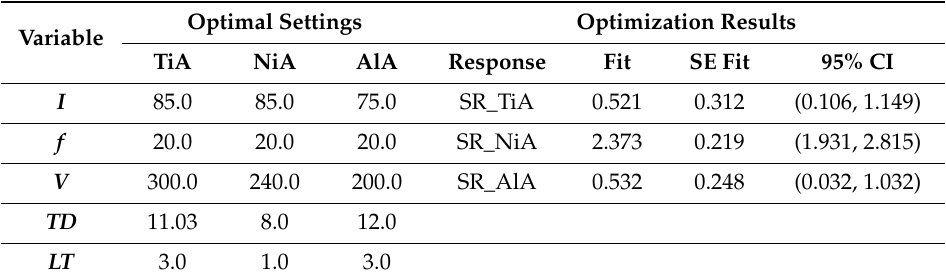
Table 7. Multiple response optimal settings and optimization results for TiA, NiA, and AlA.